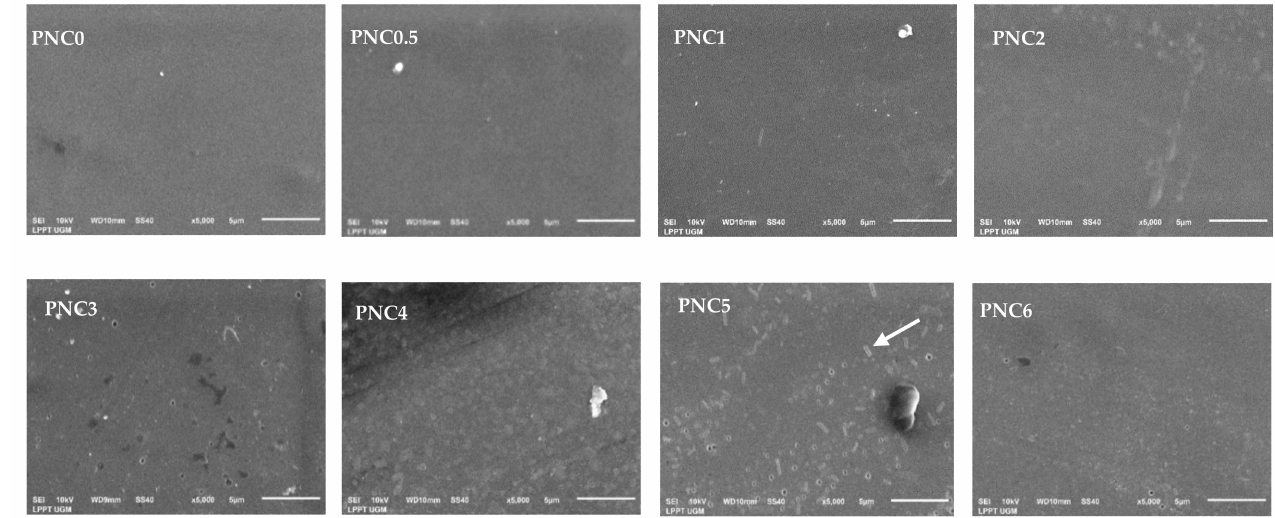
Figure 5. SEM micrographs of PVA–NCC nanocomposite